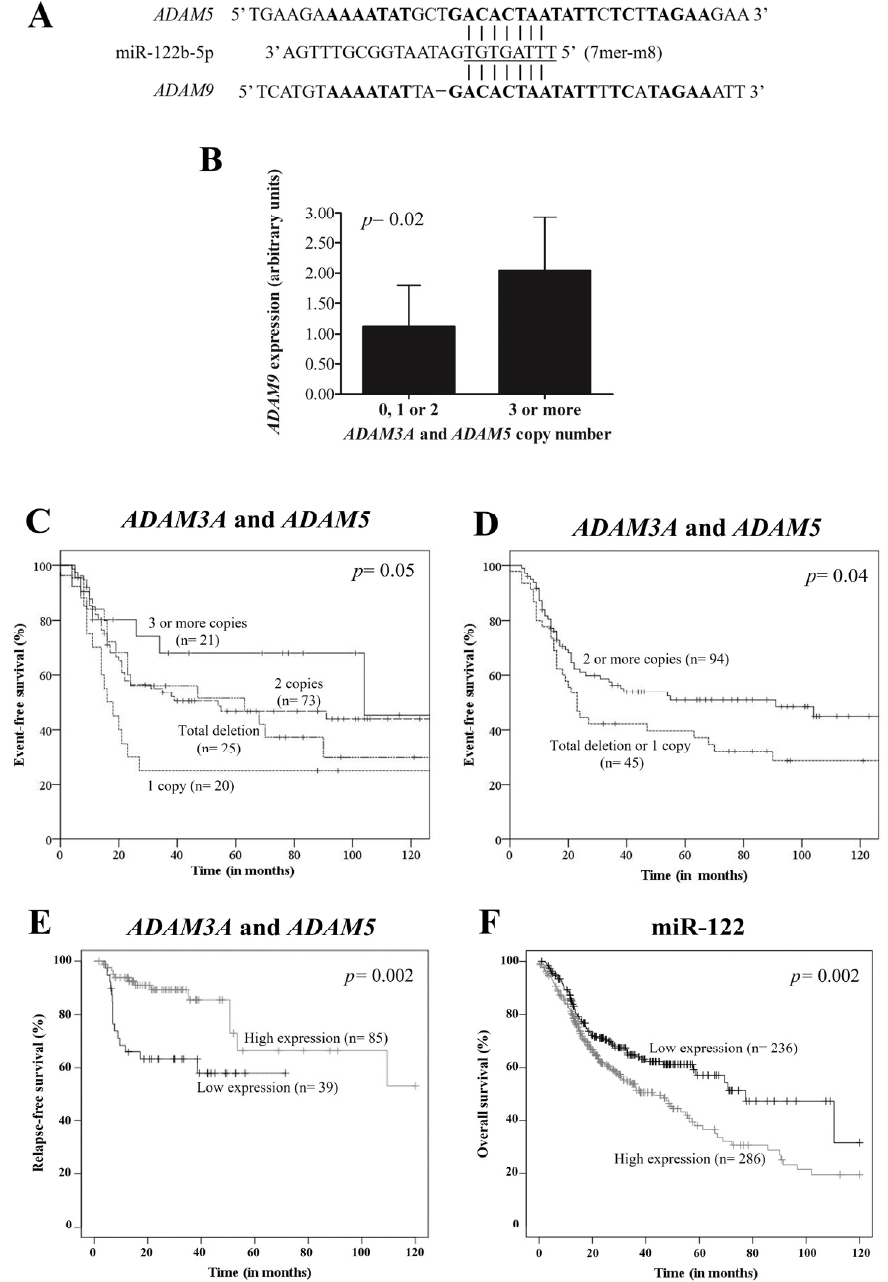
Figure 1. Potential pseudogene-microRNA(miRNA)-mRNA interaction and head-and-neck squamous cell carcinoma (HNSCC) prognosis. ( A ) Predicted miRNA miR-122b-5p binding site at